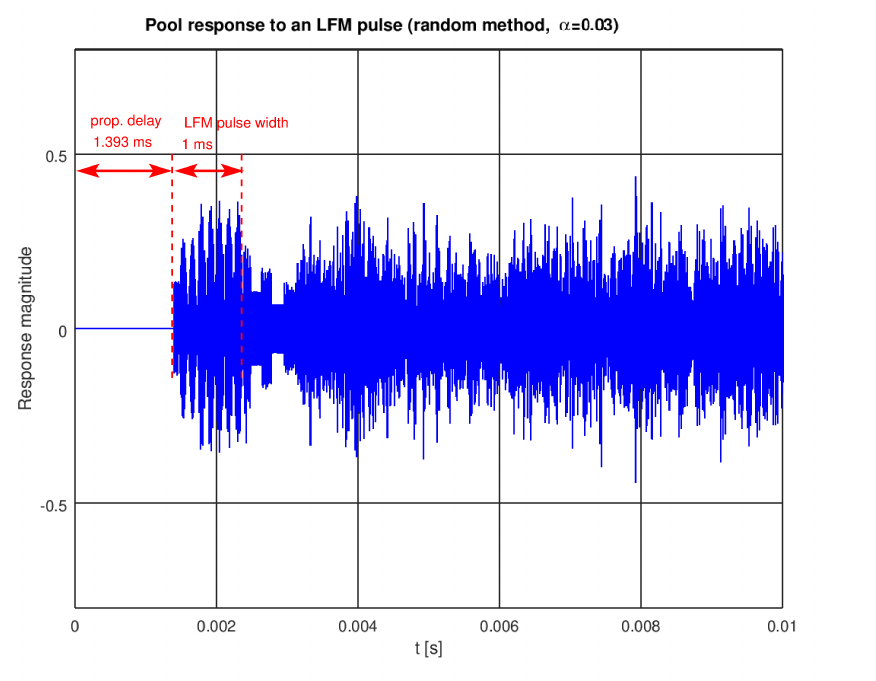
Figure 8. A response to an LFM pulse (chirp) with the model from Figure 4. Matched filtering (also referred to as correlation processing) used with an LFM signal not only improves the signal-to-noise ratio, but also allows separation of the paths by concentrating energy of each signal copy into a short correlation peak, as seen in Figure 9 (please note the additional 1 ms delay introduced by the filter).